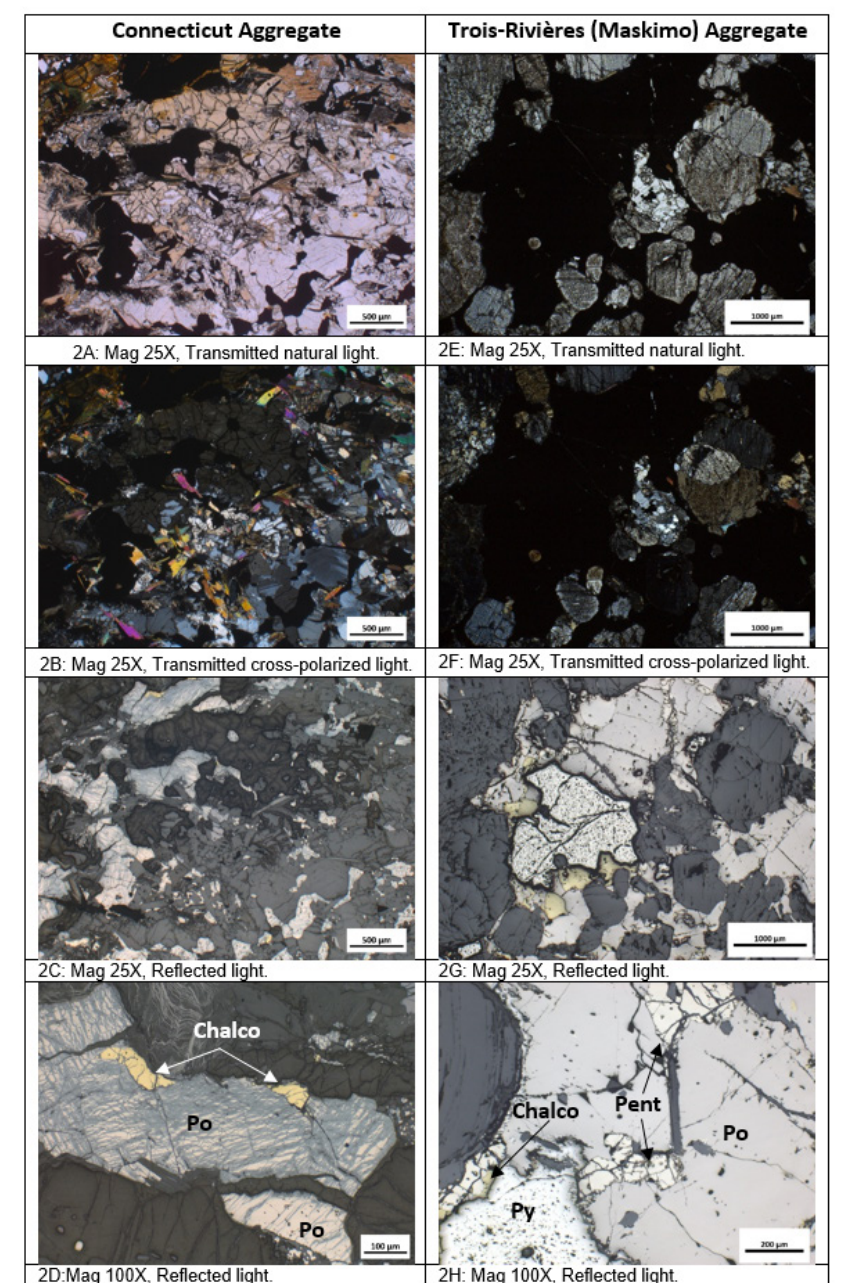
Figure 2. Comparison of the mineralogical composition of aggregates from Connecticut (left) and Trois-Rivières (right). Note: the samples are very rich in sulfides. Po: pyrrhotite; Py: pyrite; Chalco: chalcopyrite; Pent: pentlandite. Figs. 2C-2D show highly oxidized pyrrhotite. Fig. 2H shows small intergrowths of